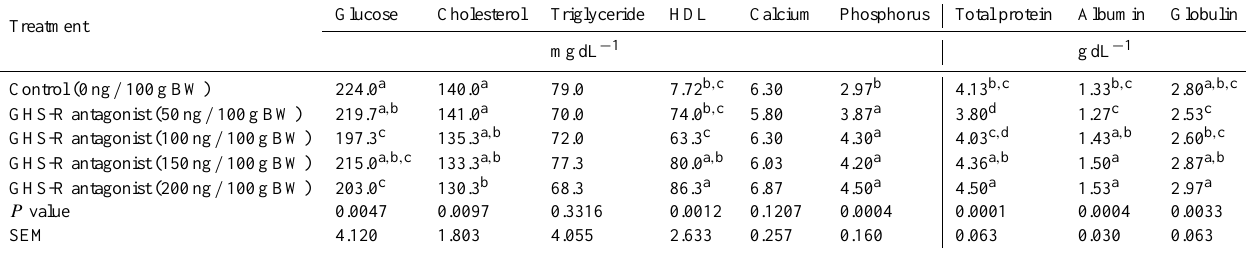
Table 3. Effects of peripheral GHS-R antagonist on biochemical parameters in broiler chicks (6h after injection). Glucose Cholesterol Triglyceride HDL Calcium Phosphorus Total protein Albumin Globulin Treatment mgdL − 1 gdL − 1 Control (0ng / 100g